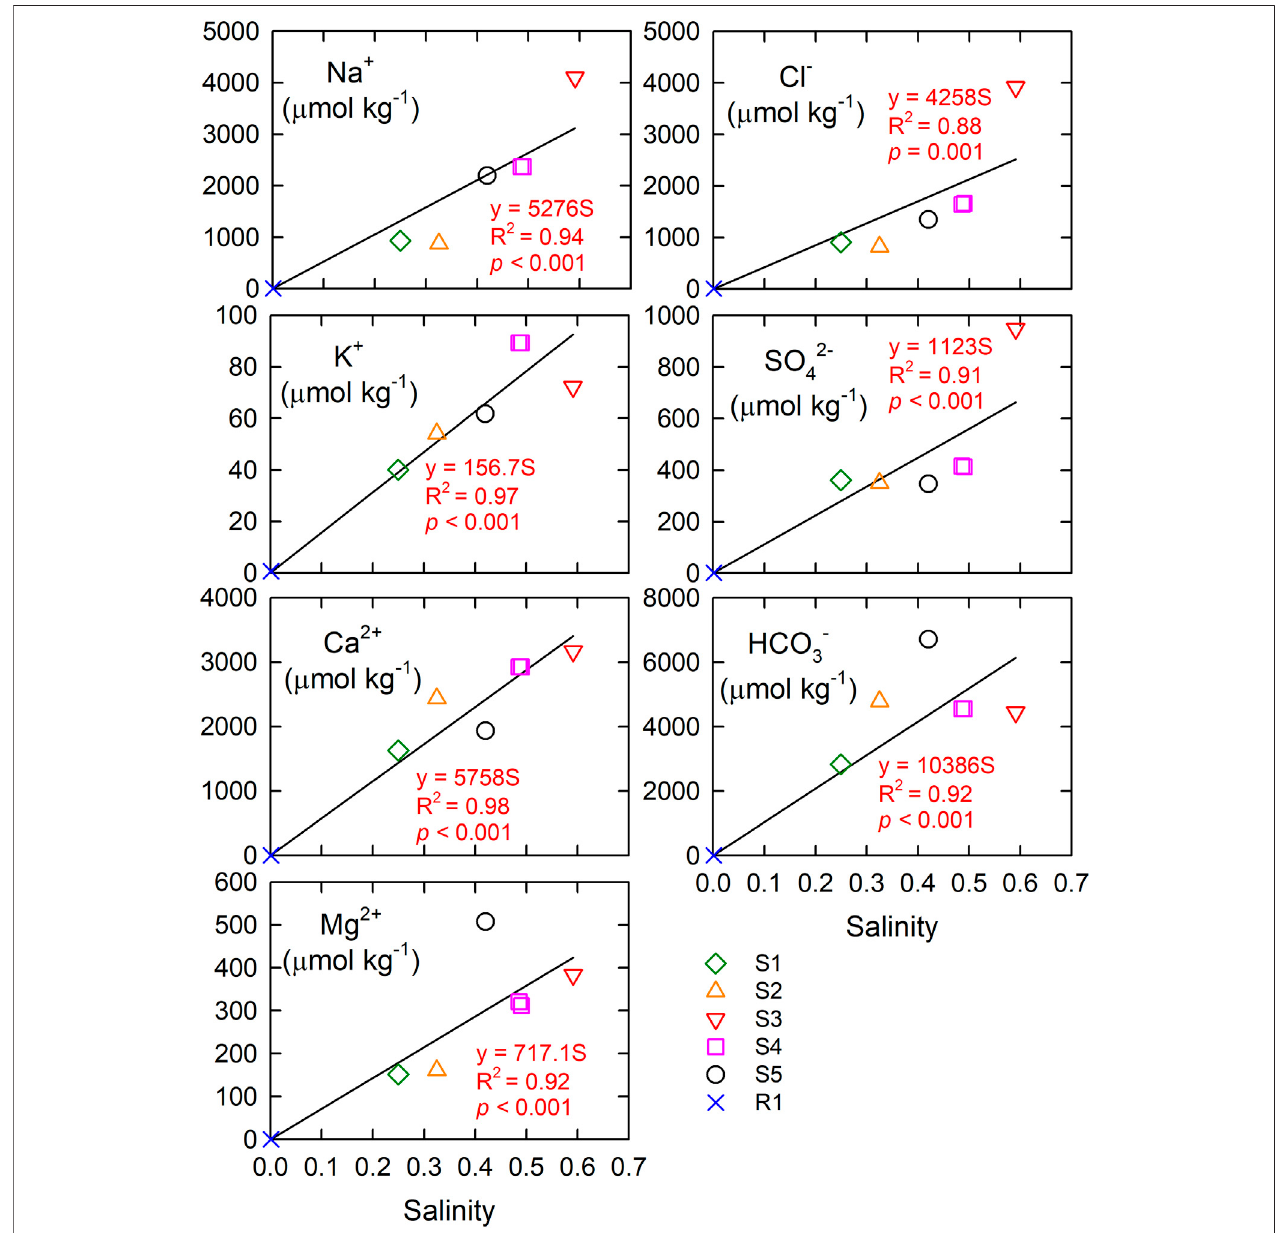
FIGURE2| Majorionsvs.salinityoftherainwateratR1andthespringwatersatS1 – S5onLiuqiuIsland.Thesolidlinesshowthelinearregressionlinespassingthe origins.